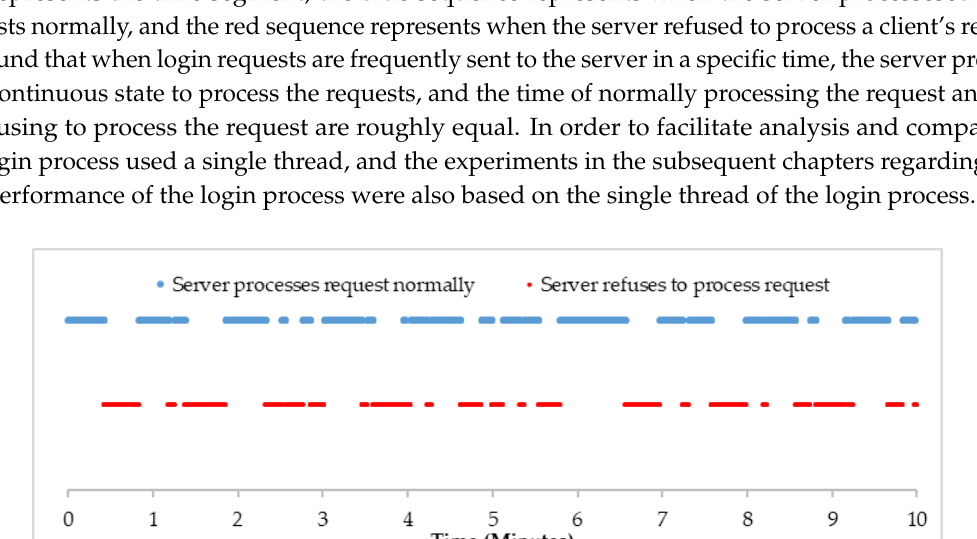
Figure 14. Time-series diagram of the login attempts of 8 server IP rotation.